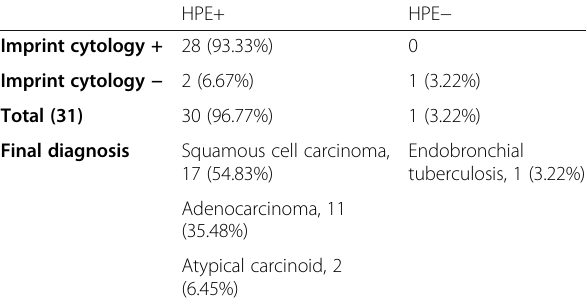
Table 3 Imprint and histopathological examination results (HPE) in the bronchoscopic group